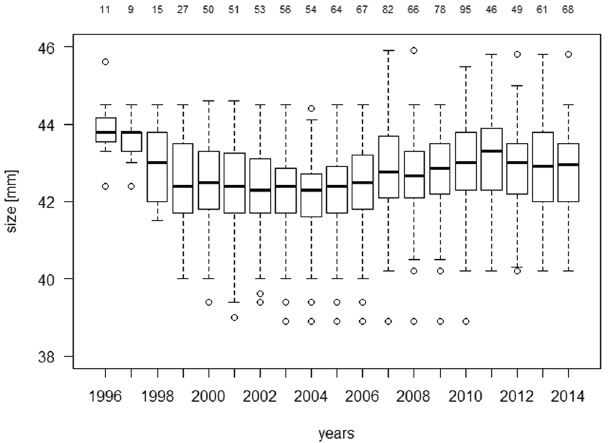
Figure 1. Distribution of forearm length in all four bat colonies over the study period. The numbers above the boxplots denote the number of adult animals in each